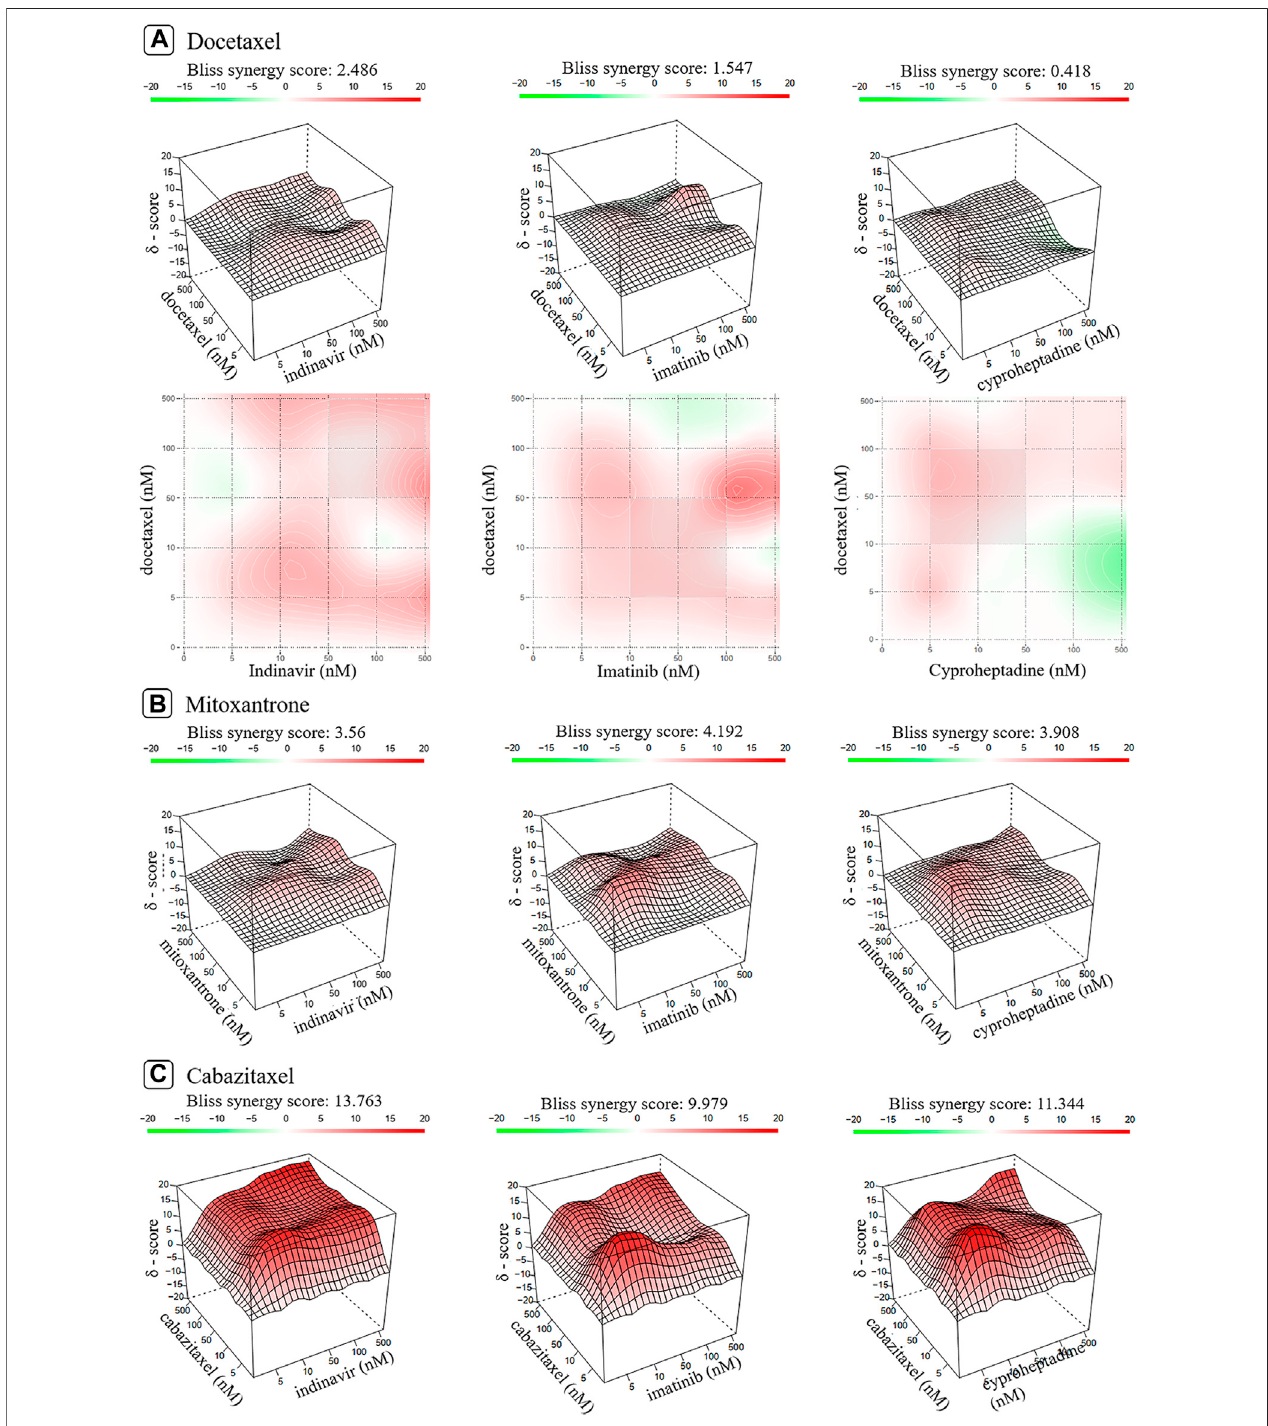
FIGURE 5 | The 2D and 3D heat maps of the combination responses for docetaxel-containing (A) , mitoxantrone-containing (B) and cabazitaxel-containing combinations (C) according to Bliss model. Red represents the synergistic interaction while green denotes the antagonistic interaction.